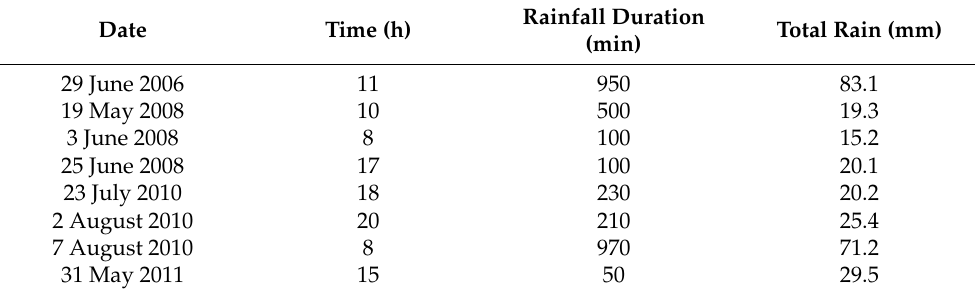
Table 4. The overview of the episodes used for field-scale rill flow validation.